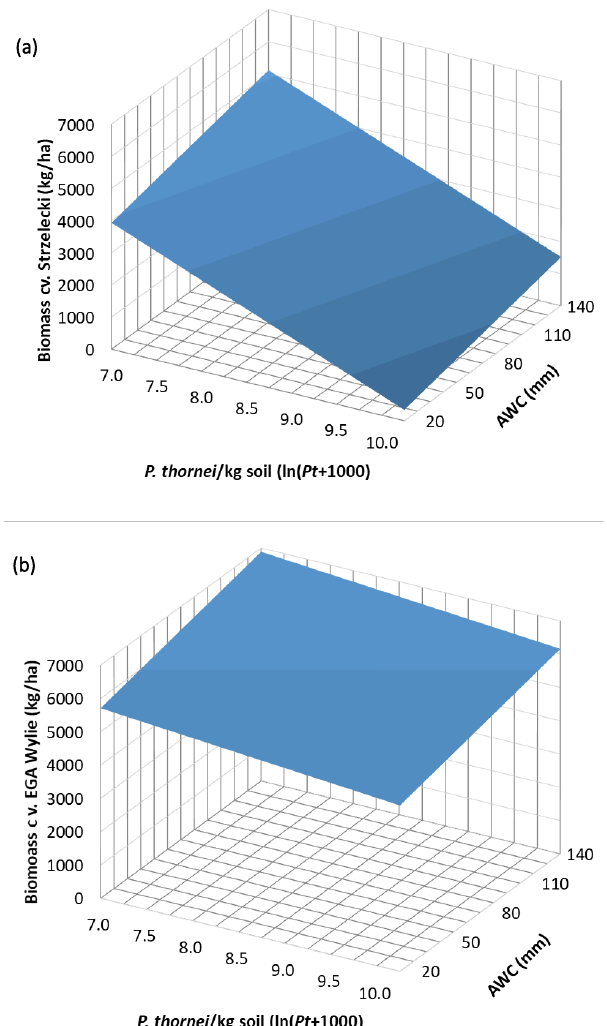
Figure 4. Relationship between biomass (kg/ha) of the Phase 2 wheat cvs ( a ) Strzelecki or ( b ) EGA Wylie at grain filling and population densities of Pratylenchus thornei /kg soil (ln( Pt + 1000)) and available water content (AWC mm) at 0–0.9 m soil depth following the Phase 1 crop cultivars and weed-free fallow treatment; for combined wheat cultivars p < 0.001; n = 288; R 2 = 0.73; SE, standard error of the equation parameters. 𝐵𝑖𝑜𝑚𝑎𝑠𝑠 𝑐𝑣.𝑆𝑡𝑟𝑧𝑒𝑙𝑒𝑐𝑘𝑖 = 11487 (SE 1684) + 9.822(𝐴𝑊𝐶) (SE 2.888) − 1107(ln(𝑃𝑡 + 1000) (SE 183.1) AWC p < 0.001; P. thornei p < 0.001